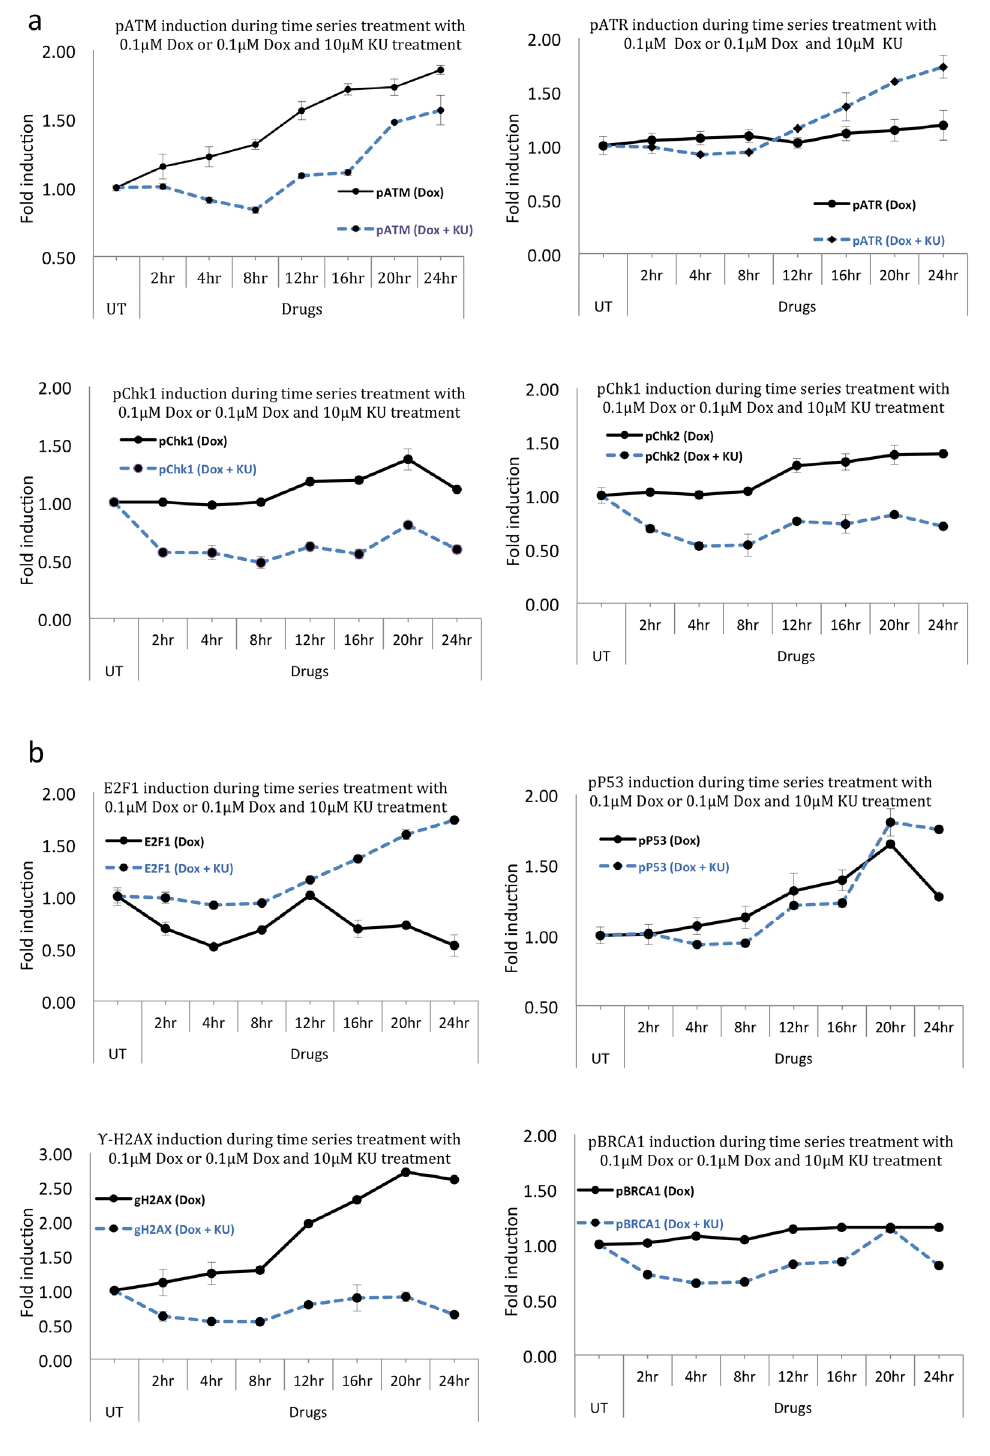
Figure 6. Time dependent double stranded DNA damage-induced signalling profiles of DDR transducers and effectors following 100nM Dox with and without ATM kinase inhibition. HaCat cells were seeded at a density of 2.5 x 10 3 cells in quadruplicates in 96-well plates. After 24 h, cells were either left untreated, treated with 100nM Dox alone or with a combination of 100nM Dox + 10μM KU for indicated time points and processed for ELISA as described in materials and methods. Following this, cells in each well were incubated with primary antibody against (a) DDR kinases pATM S-1981, pATR S-428, pChk1 S-345 and pChk2 T-68 and (b) DDR substrates pP53-S 15, γH2AX S-139, E2F1 and pBRCA1 S-1524 as indicated in figure and Horseradish peroxidase conjugated secondary antibody (Cell Signalling) followed by using Amplex Red® (Invitorgen) detection system. Readings were taken in 96-well fluorescence multi plate reader (Modulus Template®) using excitation and emission spectra of 530.590 nm. Values are means of fluorescent readings acquired from quadruplicates of treatments and normalised to the mean fluorescence of untreated control (UT) expressed as 1. Data is based on n=3 independent